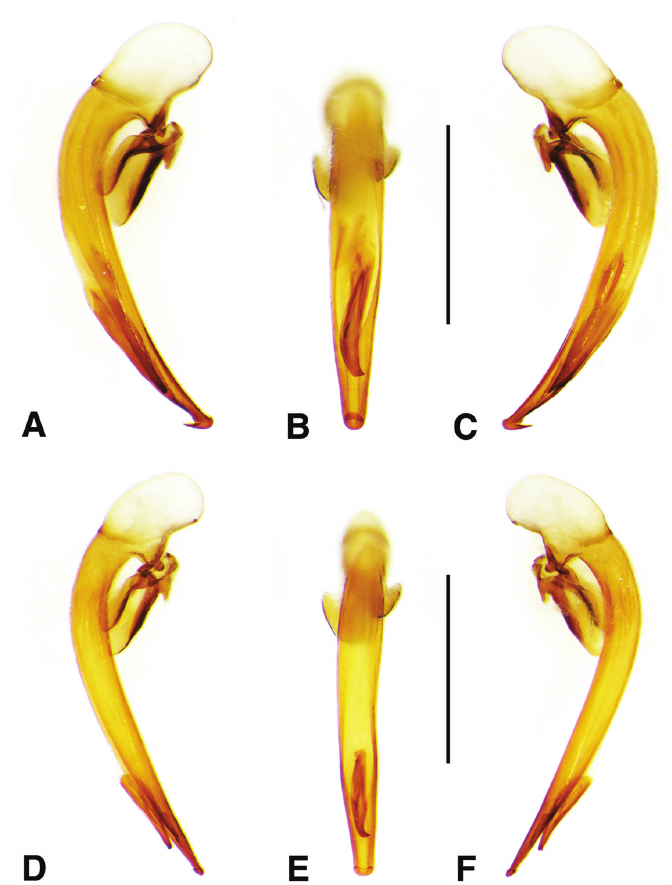
Figure 15. Digital images of male genitalia of Selenophorus discopunctatus species group. A, D right lateral aspect B, E dorsal aspect C, F left lateral aspect. A–C S. discopunctatus Dejean D–F S. yucatanus Putzeys. Scale bars 1